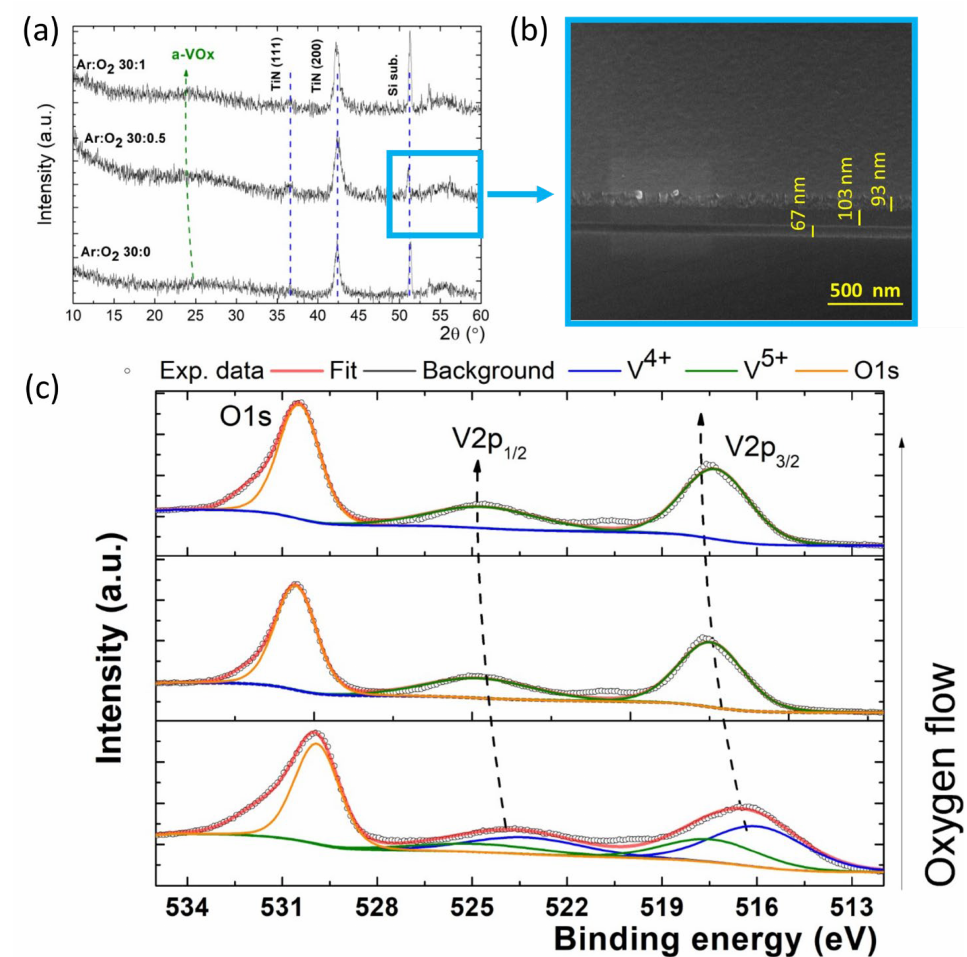
Figure 1. ( a ) The XRD patterns of the heterostructures with vanadium V x O y films deposited in different Ar:O 2 flux conditions. ( b ) Cross-view SEM micrograph of a Si/SiO 2 /V x O y /TiN heterostruc- ture with V x O y film obtained in Ar (30 sccm): O 2 (0.5 sccm) plasma. ( c ) The XPS fit on the V2p and O1s